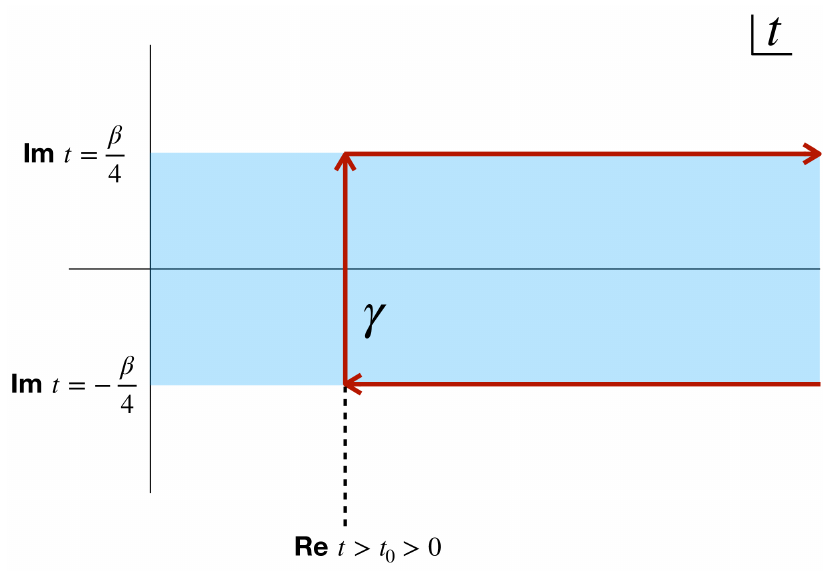
Figure 3 . The contour γ is used for deriving bounds on moments of the